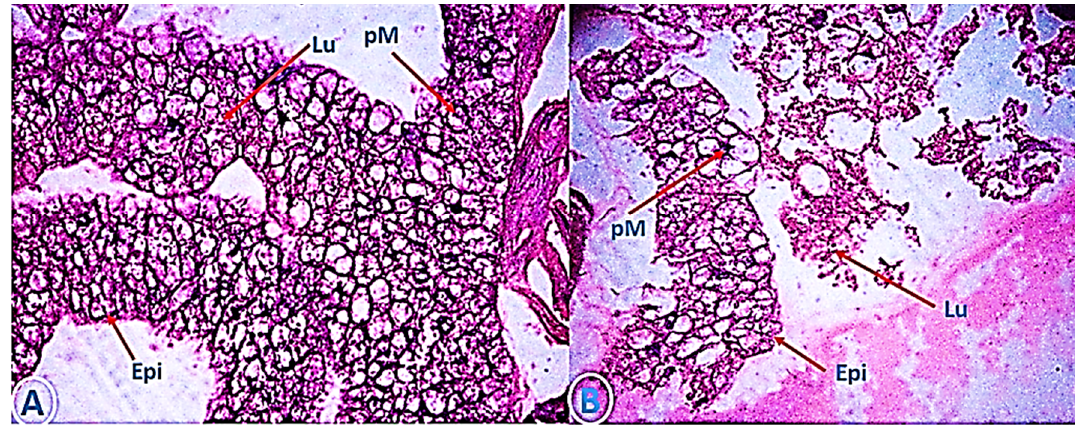
Figure 6. Cross-section through mid-gut of fourth instar Ae. aegypti treated with My-It. ( A ), control, compared with ( B ), treated. (Epi) vacuolated gut epithelium; (Lu) gut lumen; (pM) peritrophic membrane.